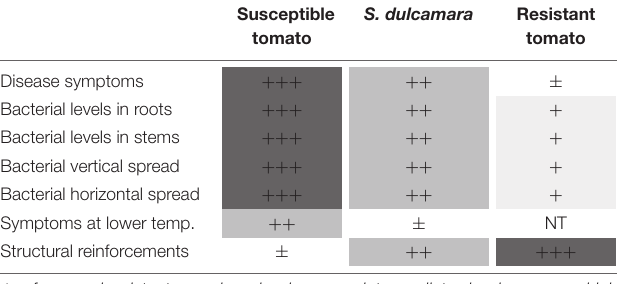
TABLE 1 | Schematic comparison of the interaction at different levels between R. solanacearum and a susceptible tomato, S. dulcamara , and a resistant tomato. Susceptible